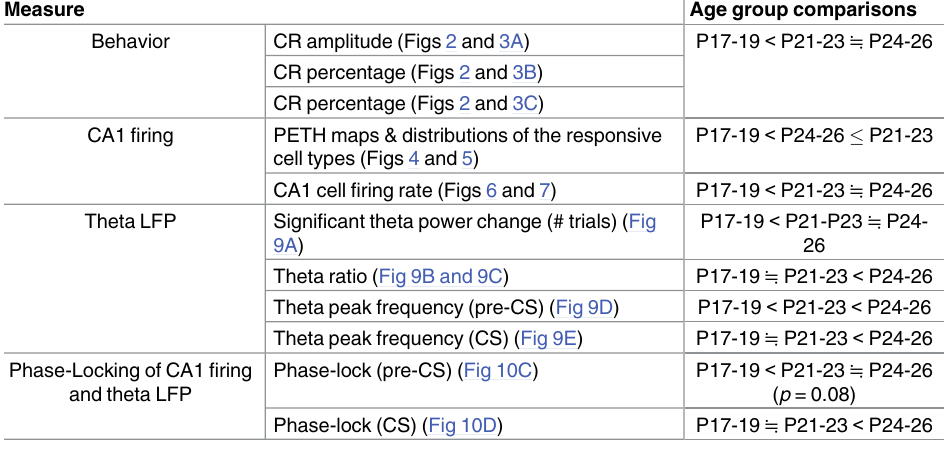
Table 2. Summary of behavior, CA1 firing, theta analyses and CA1-theta phase-locking results from three postnatal days (P) 17–19, P21-23, and P24-26 in delay eyeblink